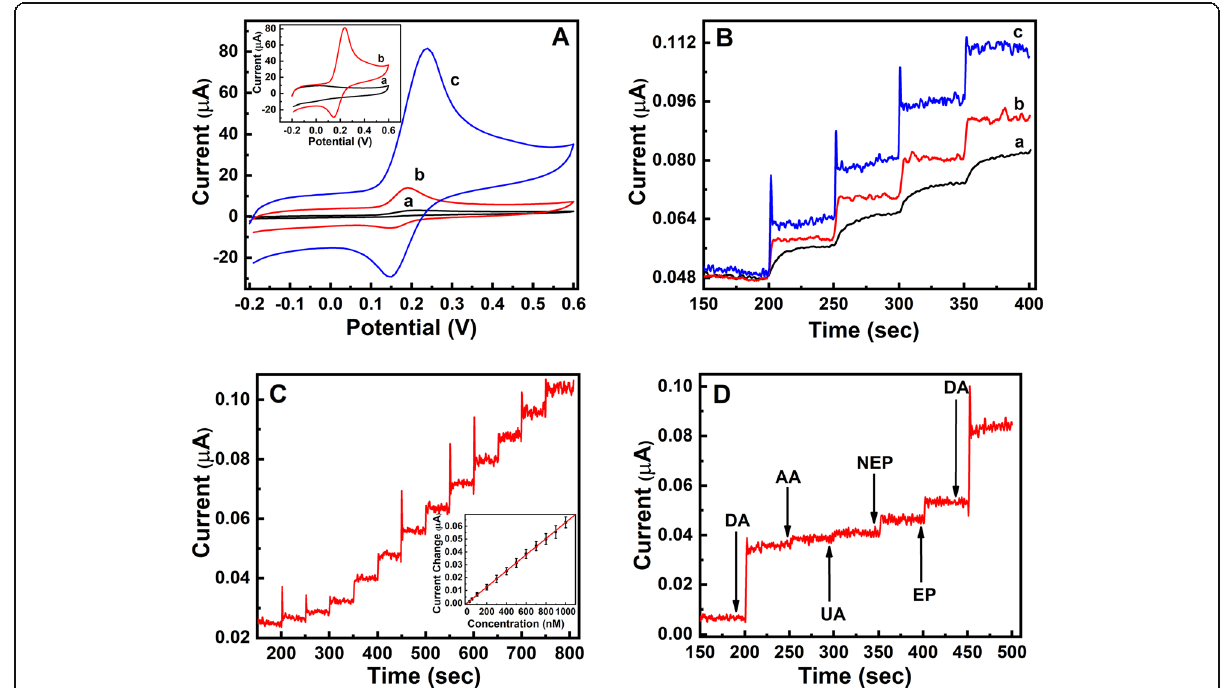
Fig. 5 A CVs of a GCE / PPy, b GCE / ErGO/PPy, and c GCE / ErGO/MWCNTs/PPy in 0.1 M PBS (pH 7.0) containing 50 μ M DA at a scan rate of 50 mVs − 1 . Inset: CV curves of GCE / ErGO/MWCNTs/PPy in the absence ( a ) and presence ( b ) of 50 μ M DA. B Amperometric response of a GCE / PPy, b GCE / ErGO/PPy, and c GCE / ErGO/MWCNTs/PPy in 0.1 M PBS pH (7.0) containing 250 nM DA. C Amperometric response of GCE / ErGO/MWCNTs/PPy at 0.25 V in 0.1 M PBS pH (7.0) with successive addition of DA. Inset: Calibration curve for the DA sensor. D Amperometric response of GCE / ErGO/ MWCNTs/PPy for the addition of DA, AA, UA, NEP, and EP in 0.1 M PBS pH